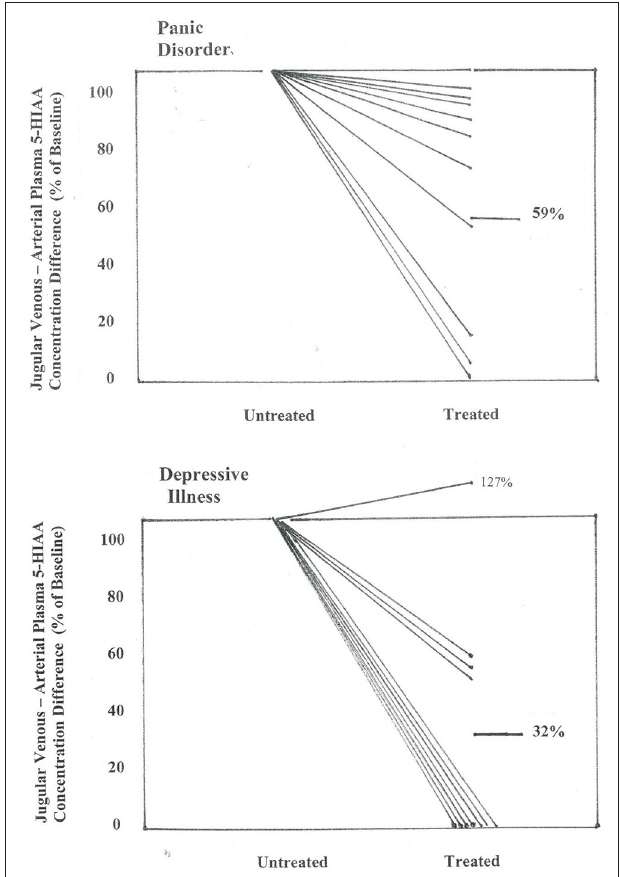
FIGURE 3 | Effect of SSRI dosing on jugular venous—arterial plasma 5-HIAA concentration difference in patients with panic disorder, and with depressive illness. Concentration differences are shown between pre-treatment baseline and after 2–3 months of SSRI administration, when clinical remission had been achieved in the majority of patients. In panic disorder patients the jugular venous—arterial plasma 5-HIAA concentration difference fell to a mean of 59% of baseline ( P < 0.01), and in patients with MDD, to 32% of baseline ( P < 0.01) (repeated measures analysis of